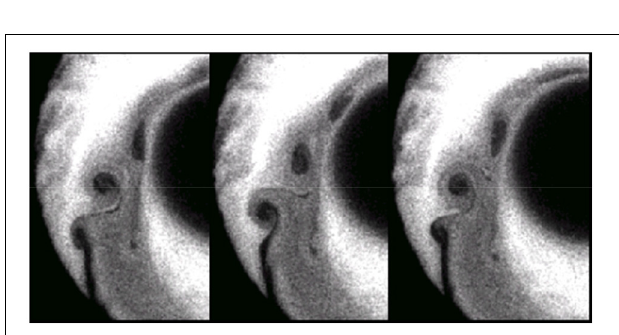
FIGURE 10 | Distribution of the charged particle densities and electric field at a given radial position at the front of the spoke in the same conditions as Figure 7, showing the double layer and associated electric field. The ionization rate profile (n e ν i ) is also shown (unit 2 × 10 20 m − 3 s − 1 ). The results are integrated in time over 100 ns.